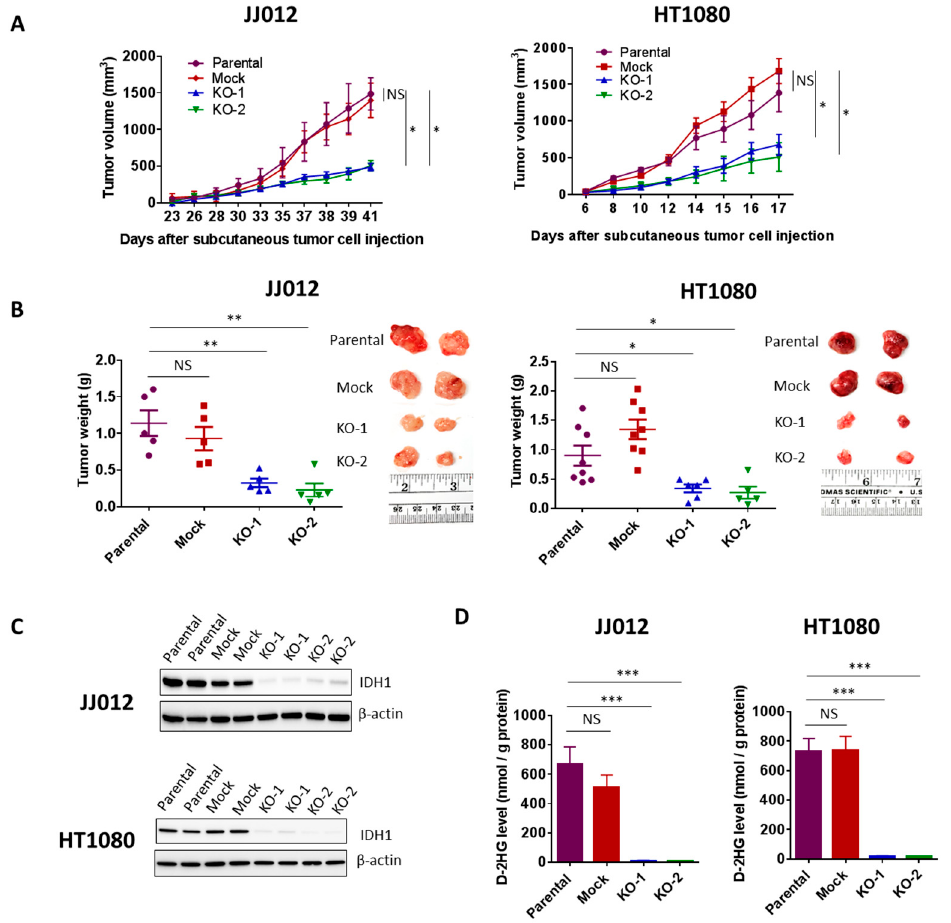
Figure 4. Loss of IDH1 mut led to suppression of chondrosarcoma formation and D-2HG production. ( A ) Effect of IDH1 mut knockout on tumor growth in subcutaneous chondrosarcoma xenograft models. 2 × 10 6 cells from each group of JJ012 or HT1080 cell were injected subcutaneously into the flanks of nude mice ( n = 8). Tumor volume was measured frequently with calipers once the tumors developed. ( B ) Tumor endpoint weight and photographs of two representative tumors from each group. Tumor weight was determined at 41 days post-injection of JJ012 groups and 17 days post-injection of HT1080 groups. Data represent average values with SEM in each group. ( C ) Immunoblots showing depletion of IDH1 in total protein lysates derived from IDH1 mut KO tumors. Two representative tumors per group are shown. ( D ) HPLC-MS analysis shows depletion of D-2HG production in the IDH1 mut KO clones-derived xenografts. Data represent mean ± SEM of at least five tumor samples from each group. * p < 0.05, ** p < 0.01, *** p < 0.001.